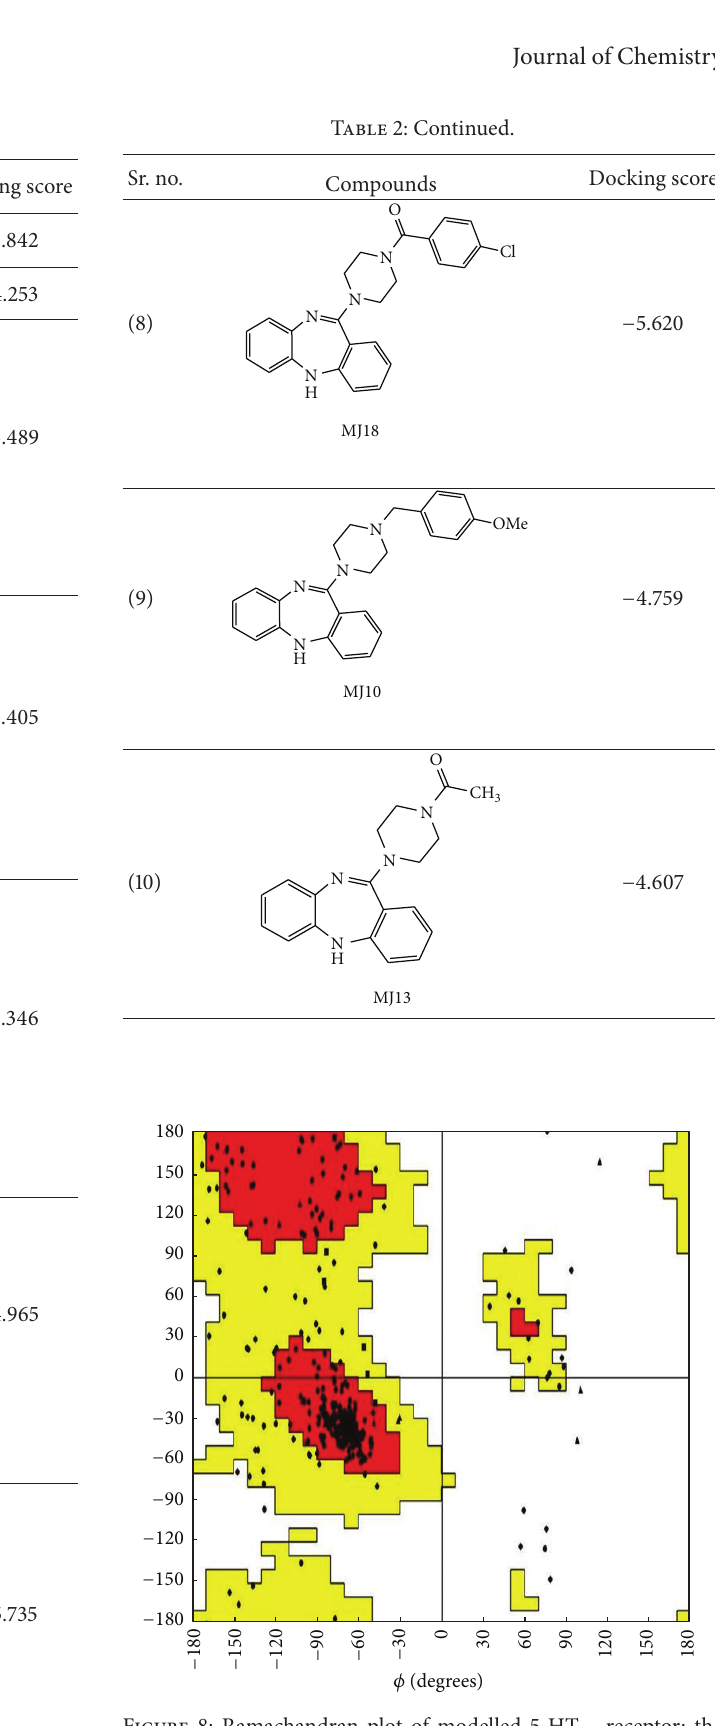
receptor; the 2A